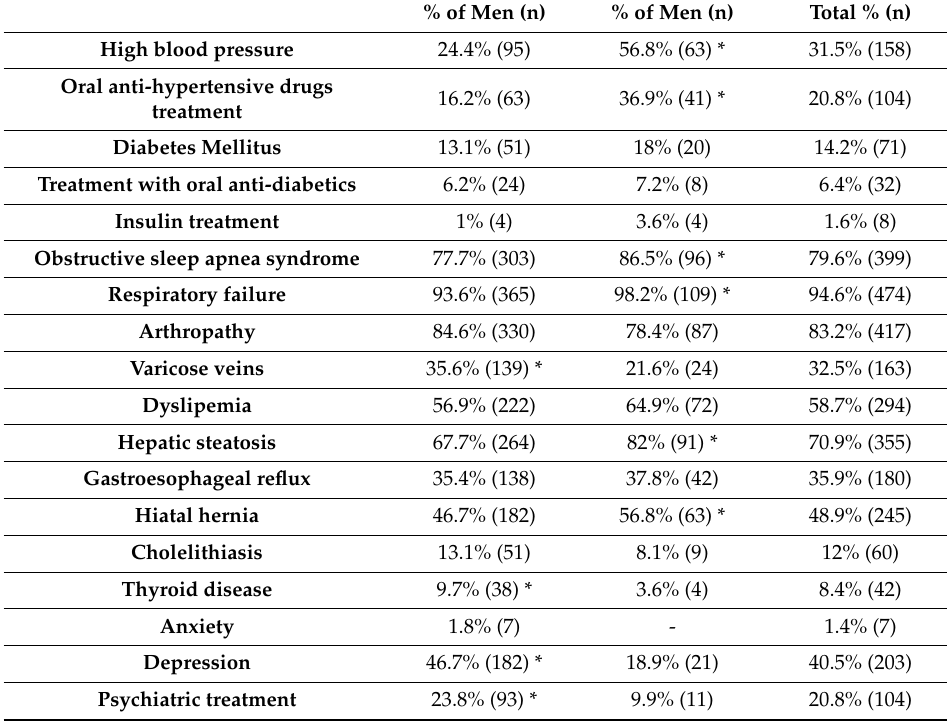
Table 1. Clinical history of the patients by gender.